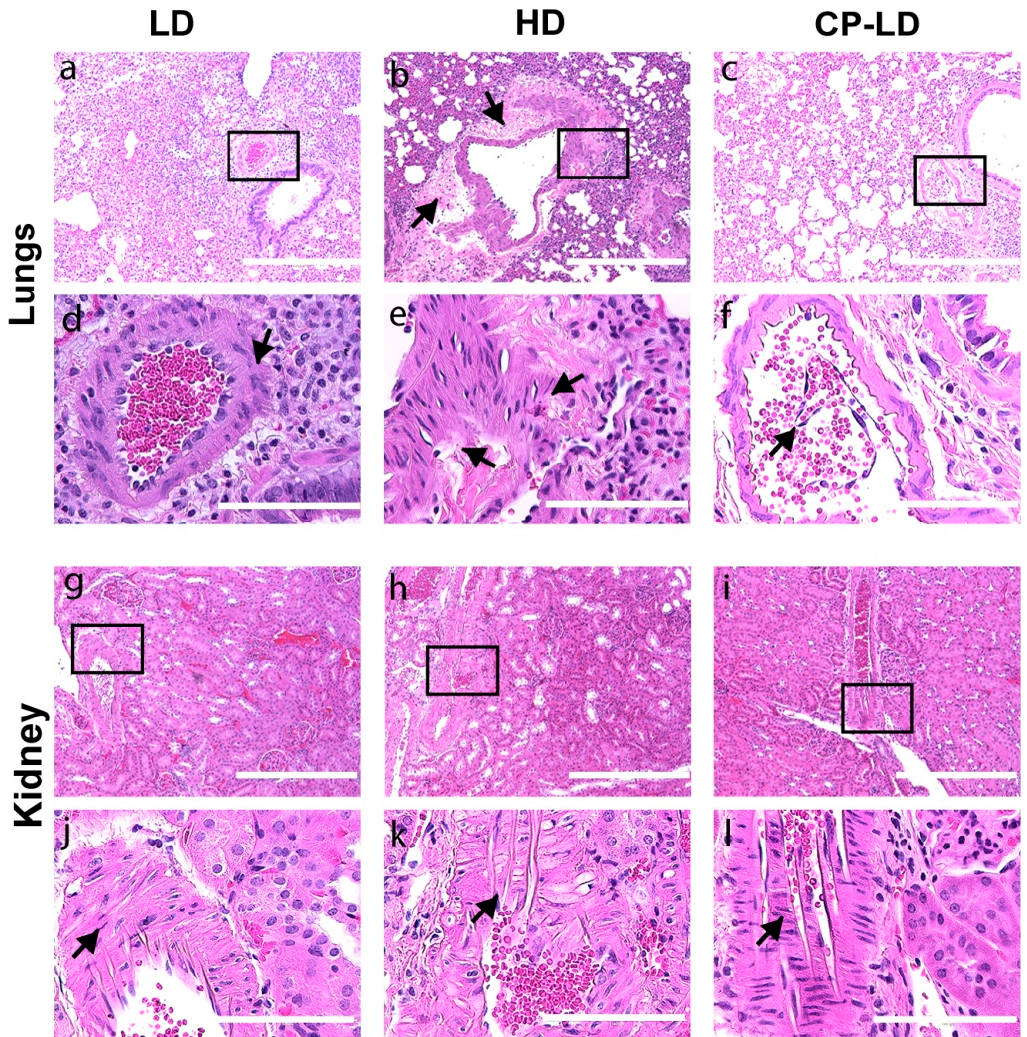
Figure 4. Arteriolar pathology in lungs and kidneys of SARS-CoV-2-infected hamsters. Histopathological analysis of pulmonary parenchyma revealed mild arteriolar smooth muscle hyperplasia ( a ), severe perivasculitis and smooth muscle hyperplasia ( b ; arrows), detachment of endothelial cells into the arteriolar lumen, and mild perivasculitis ( c ) in LD, HD, and CP-LD-infected hamsters, respectively. The images ( d – f ) are a magnification of the boxed area in ( a – c ), respectively. Moderate (LD and CP-LD) ( g , i ) to severe (HD) ( h ) vascular smooth muscle hyperplasia in the renal arterioles in SARS-CoV-2-infected hamsters. The images in ( j , k , l ) are a magnification of the boxed areas in ( g – i ), respectively. The images ( a – c , g – i ) are 100 × , and ( d – f , j – l ) are 400 × magnifications (marked in 100 × images). Scale bar represents 100 µ m ( d – f , j – l ) or 400 µ m ( a – c , g – i ).